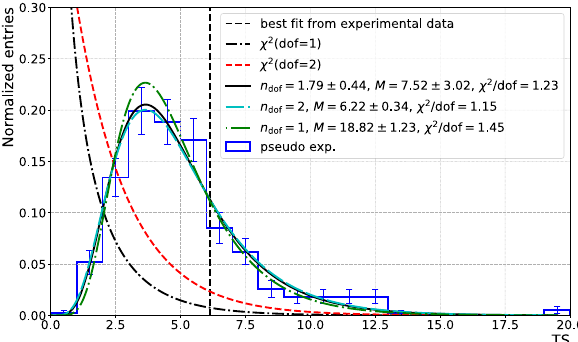
Fig. 6 Expected distribution of test statistic values as obtained from 390pseudoexperimentsofthenullhypothesis.Alsoshownistheexpec- tation for a χ 2 -distribution with one and two degrees of freedom and various modified distribution functions (see text)